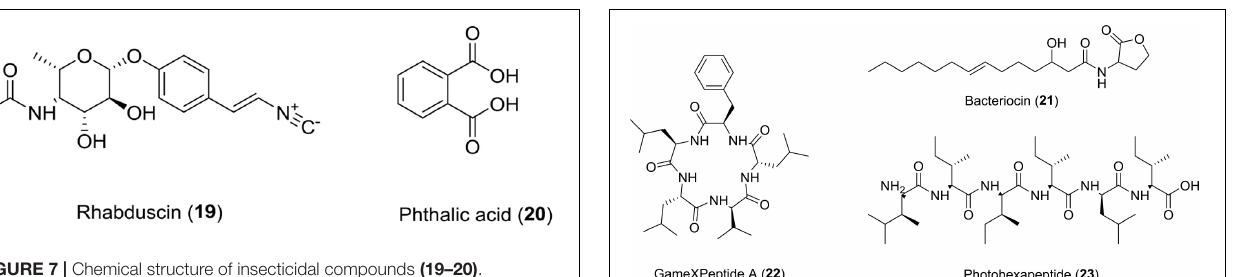
FIGURE 7 | Chemical structure of insecticidal compounds (19–20) .